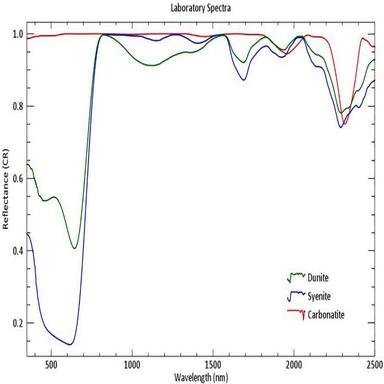
Laboratory reflectance spectra of the samples.